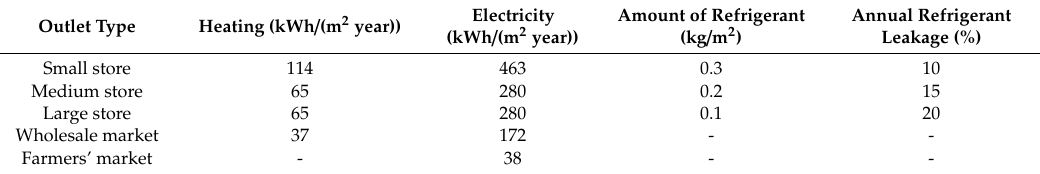
Table 8. Energy use and refrigerant indicators for defined outlet types.